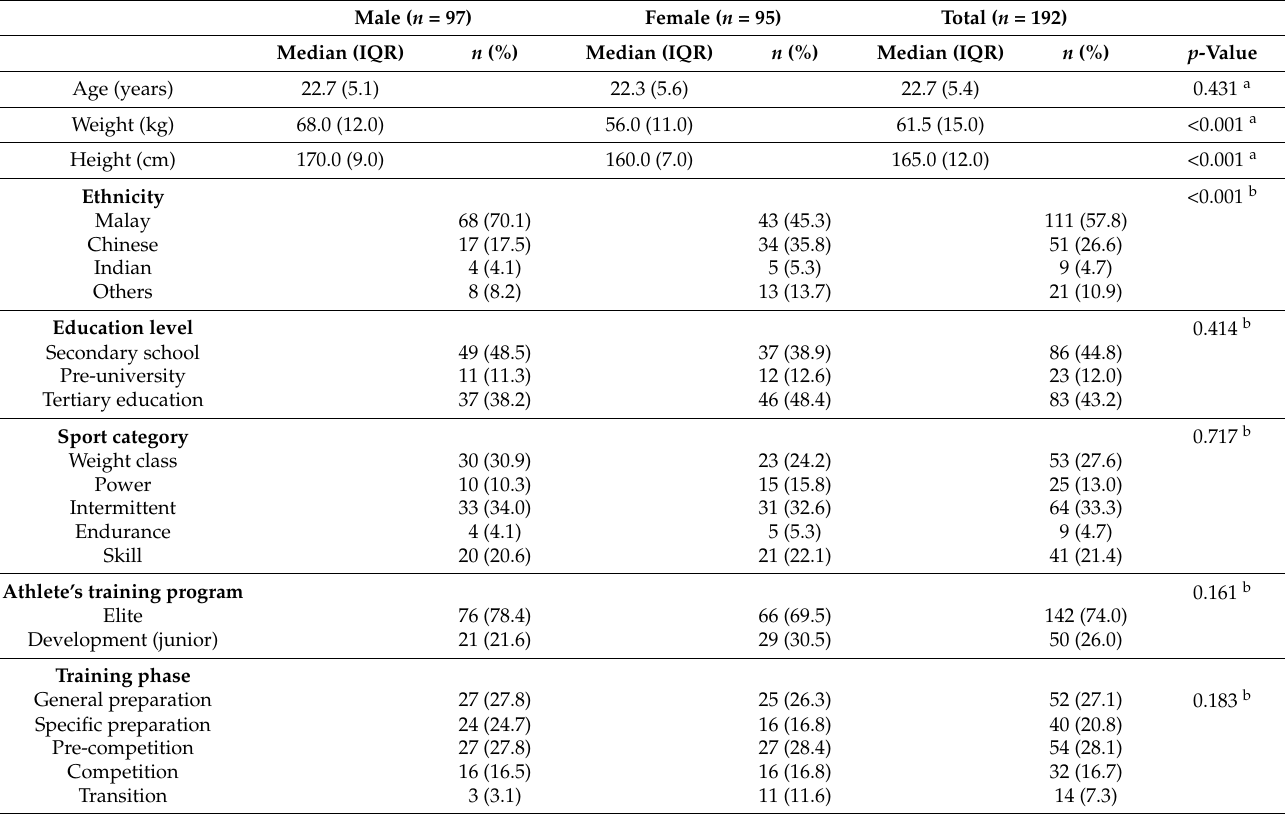
Figure 1. Recruitment of study participants. Table 1. Physical characteristics and sociodemographic pro fi les of athletes.